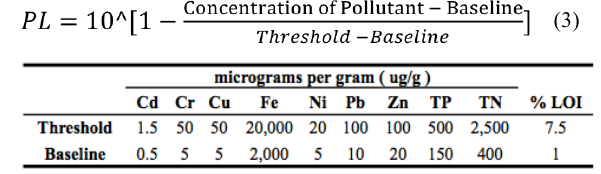
Table 1: Baseline and threshold values for calculation of pollutant loads adopted from Jeffrey et al . (1985). The PLI of each site was then calculated using equation (4).